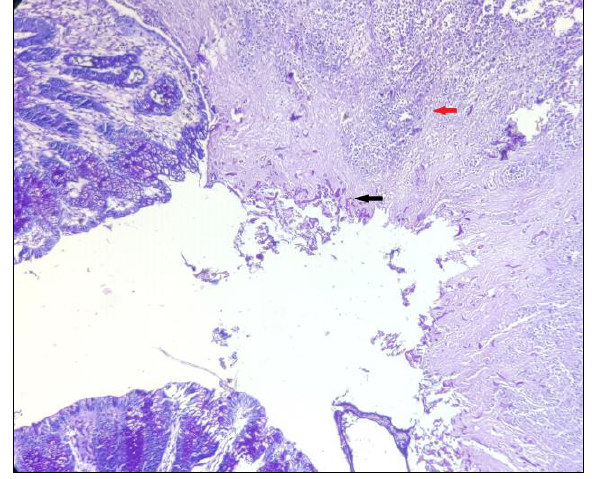
Figure 1: Micro-sections from gut revealing dense inflammatory infiltrate (yellow arrow), numerous multinucleated giant cells (red arrow), and fungal hyphae (black